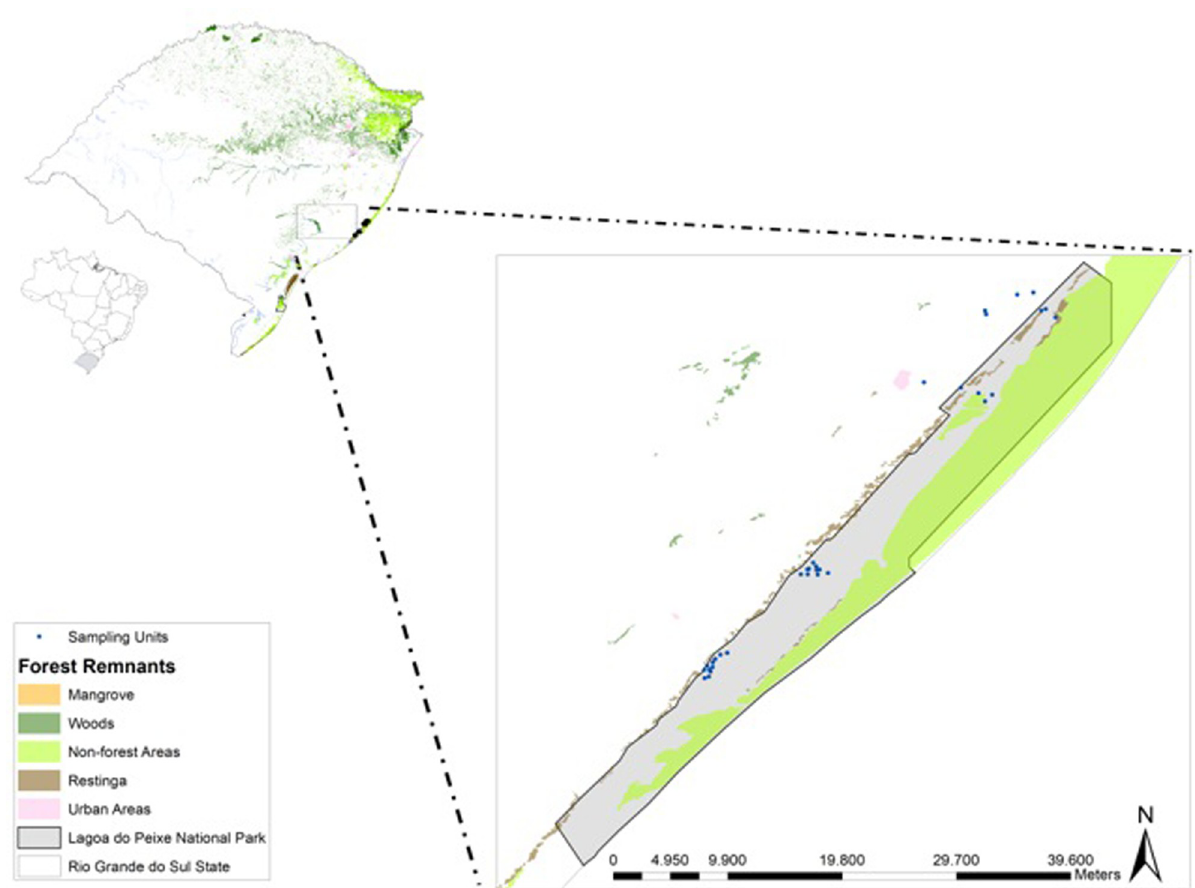
Fig 1. Study area at Lagoa do Peixe National Park, southern Brazil. Sampled ponds are represented by blue circles.